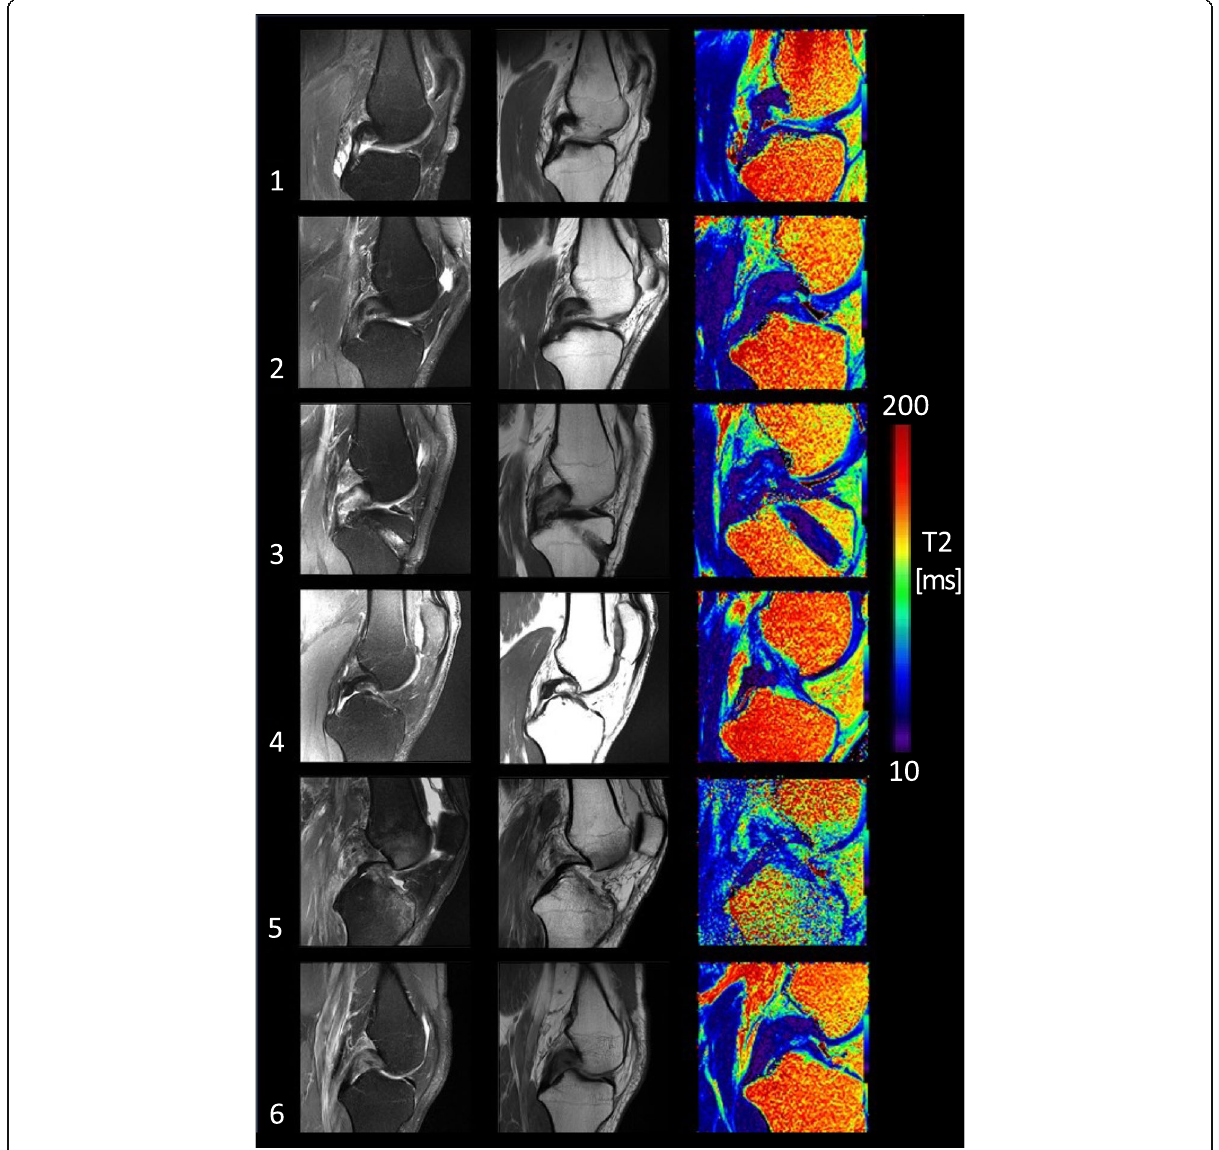
Fig. 2 Example MR images in the six individual patients with PCL insufficiency showing a continuous ligament. Images show the closest sagittal slice through the middle of the injured PCL for each of the following sequences: PD FS TSE, PD TSE and color-mapped T2 mapping